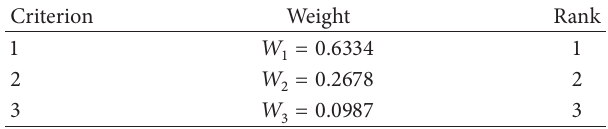
Table 1: The result of ranking of proposed method.